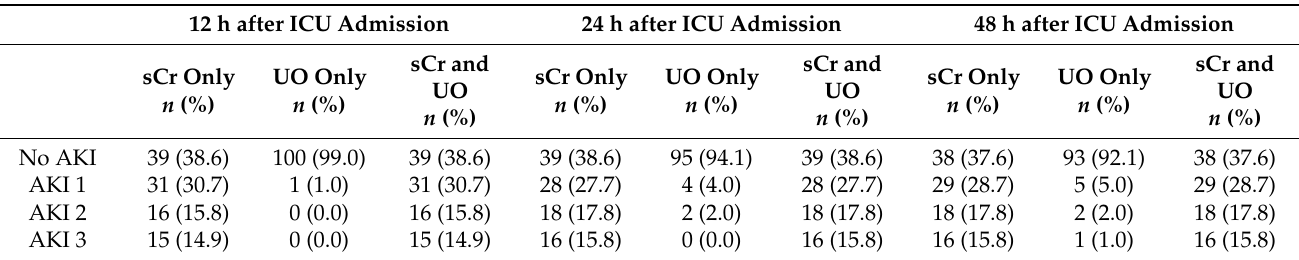
Table 2. Acute kidney injury based on KDIGO